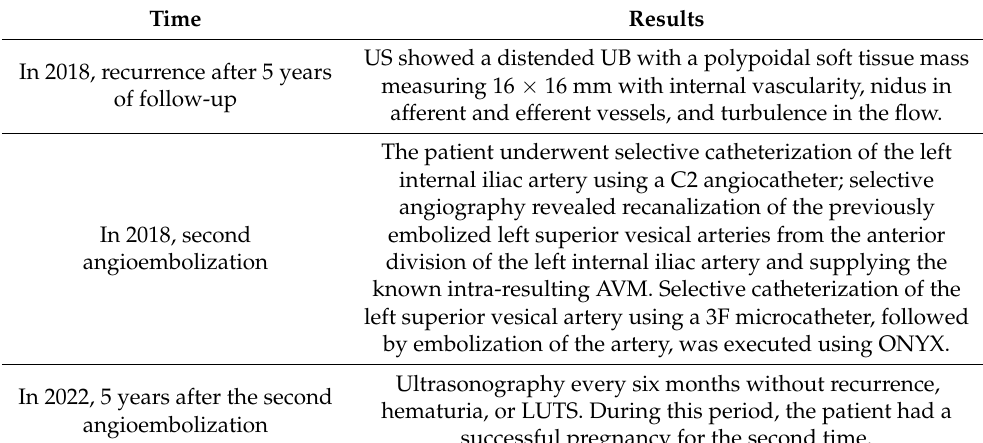
Table 2. Summary of the